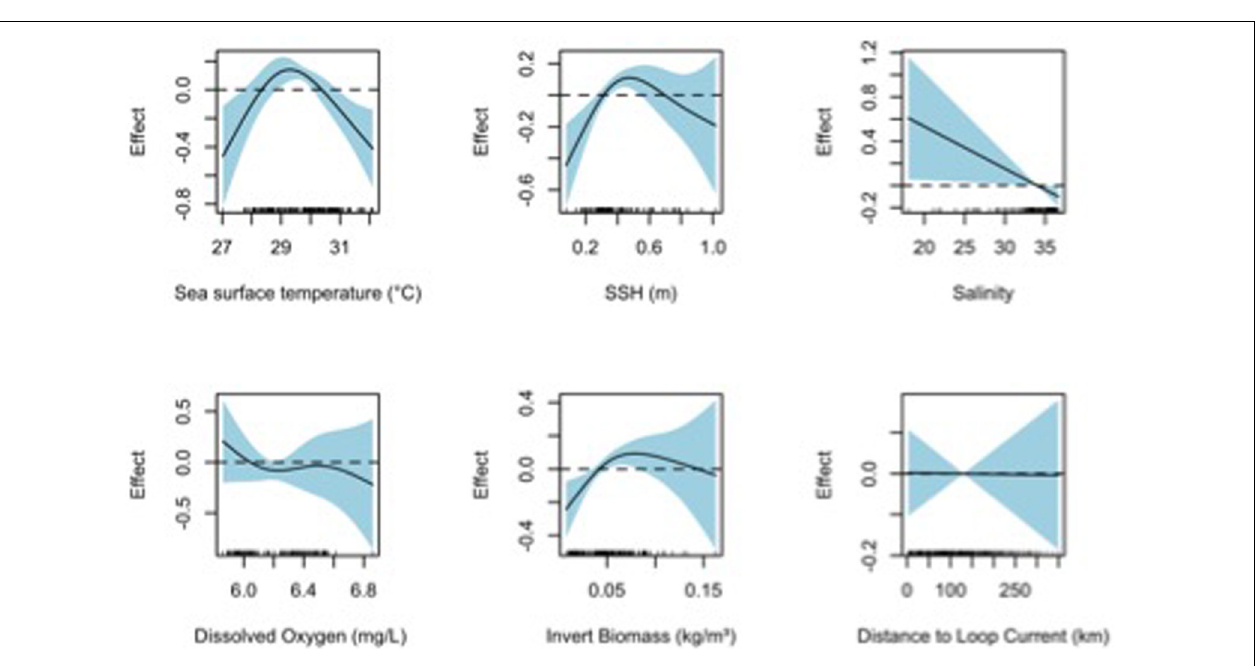
Frontiers in Marine Science |